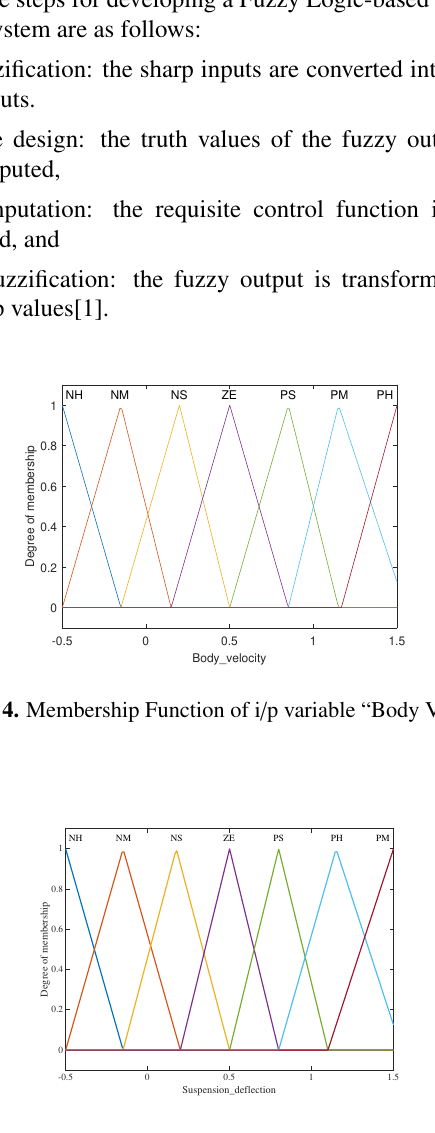
Figure 5. Membership Function of i / p variable “Suspension De- flection”